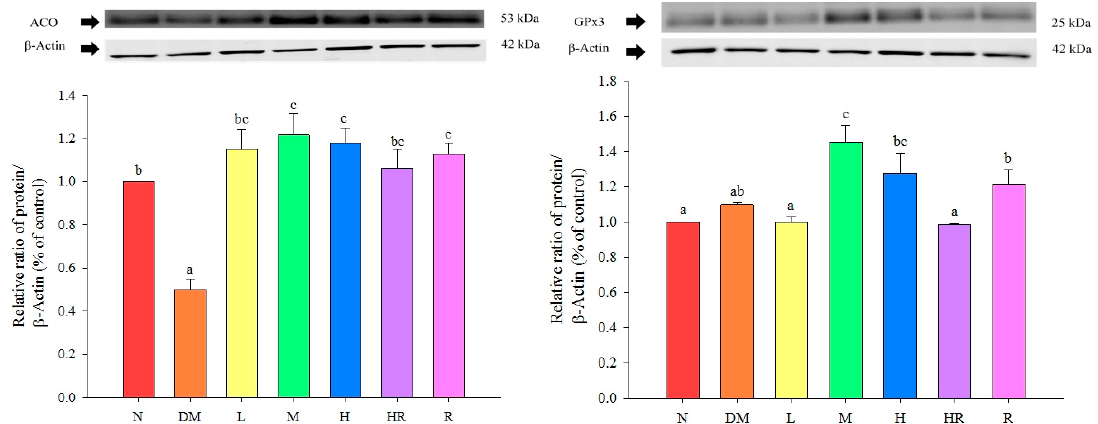
Figure 1. Influence of red guava on ACO and GPx3 protein expression in mouse livers. The treatments were as follows: normal (N), diabetes mellitus (DM), diabetes + red guava 1% (L), 2% (M), and 5% (H), diabetes + 5% red guava + anti-diabetic rosiglitazone (HR), and diabetes + anti-diabetic rosiglitazone (R). Values are expressed as mean ± SD of each group. The lowercase letters above the bars indicate significant differences ( p < 0.05).